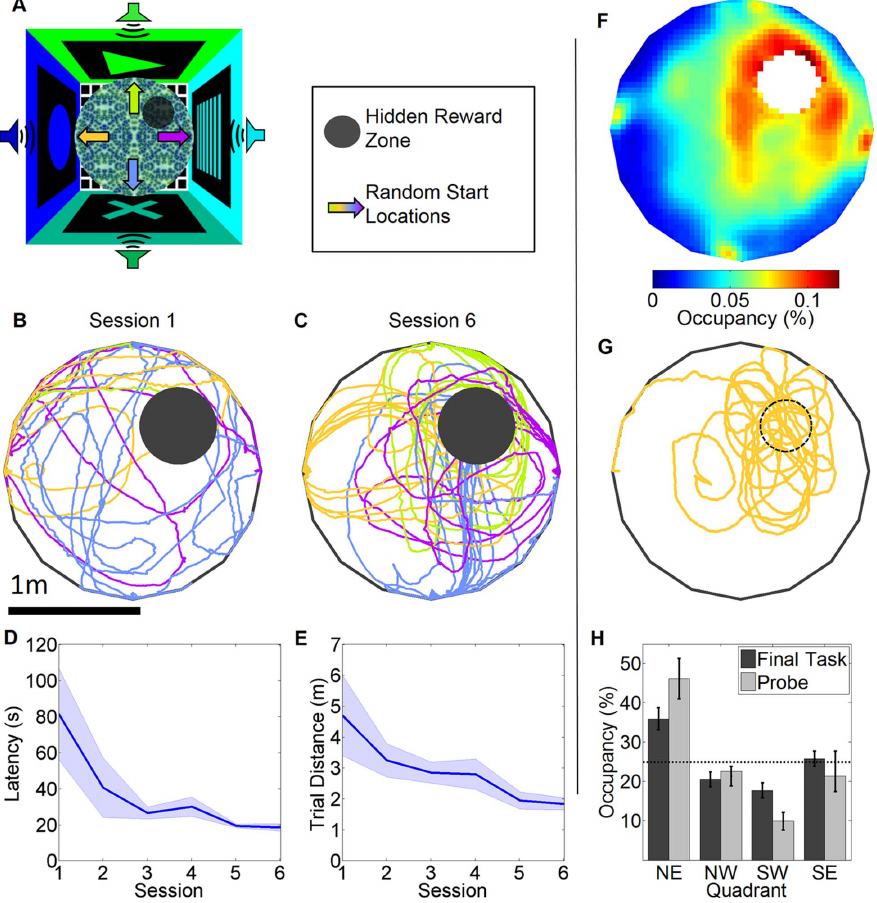
Figure 1. Navigational performance in the virtual audiovisual spatial navigation task. (A) Schematic of the virtual environment indicating distal auditory and visual cues and a hidden reward zone and the four start locations. (B) Example paths from a single rat from the 1 st session. The color of each path indicates start location, color coded from the arrows in A. (C) Example paths from the same rat from the 6 th session. (D) Acquisition curve of latency to reward across sessions. F(5,35) =4.266, p=0.0061, Session 1 vs. Session 3: p , 0.05, N= 6. (E) Acquisition curve of the distance traveled to reward across sessions. F(5,35) =3.00, p=0.0296, Session 1 vs. Session 5: p , 0.05. (F) 2-D histogram of mean occupancy averaged across final four task sessions of asymptotic performance with the smaller reward zone. (G) Example of a probe trial path. (H) Percentage quadrant measures for occupancy time during the final four task sessions performance and during the probe trial. Effect of quadrant: F(3,23) =10.15, p=0.007, F(3,23) =10.9, p=0.0005,